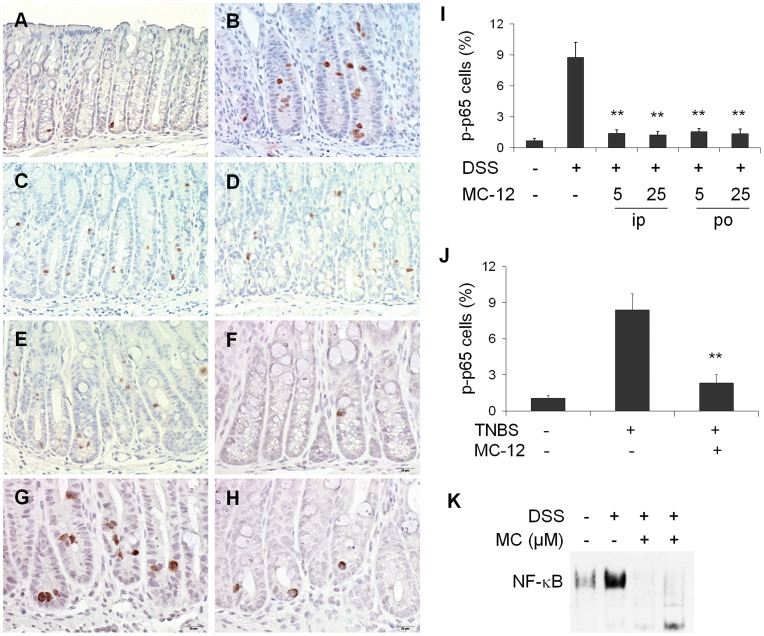
MC-12 inhibits NF-κB activation induced by DSS and TNBS in vivo and in vitro.Colon tissue sections were immunohistochemically stained with anti-phospho-NF-κB p65 antibody. Normal colon mucosa from C57BL/6 mice (A) or from SJL/J mice (F) shows a few cells with p-p65 nuclear positive staining. Colon mucosa with DSS (B) or TNBS (G) shows increased NF-κB nuclear-positive cells, most of which are crypt epithelial cells. Markedly less p-p65 nuclear translocation was shown in colon mucosa from DSS model treated with MC-12, 5 mg/kg ip (C), 25 mg/kg ip (D) or 25 mg/kg po (E) or from TNBS model treated with MC-12 25 mg/kg ip (H). Changes in p-p65 nuclear positive, evident in the photos are quantified (I, J). DSS increased NF-κB-DNA binding in NCM460 cells determined by EMSA, and MC-12 30 and 300 µM significantly blocked this effect (K). Values are mean ± SEM. **p<0.01 compared to vehicle-treated group. IHC staining; magnification 200x.